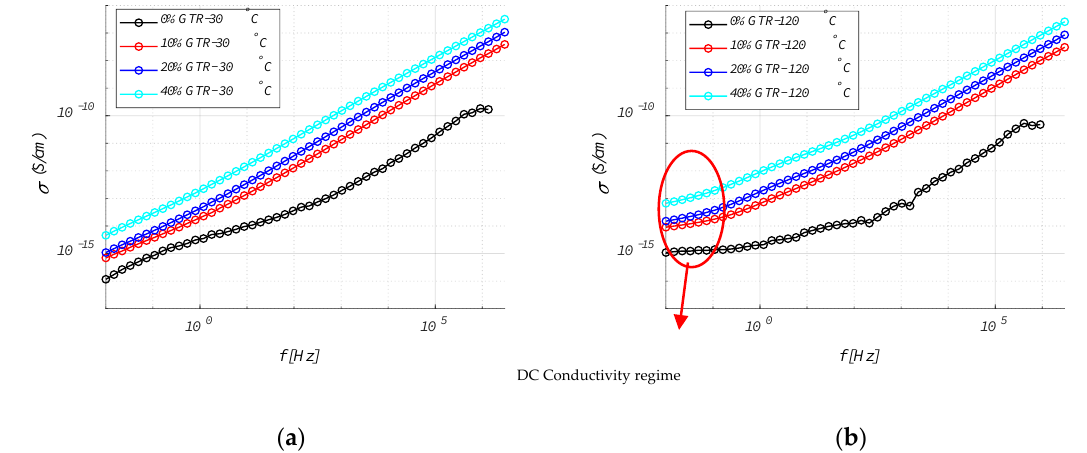
Figure 7. Conductivity (σ) for HDPE/GTR compounds at 30 °C ( a ) and 120 °C ( b ), depending on frequency.